Question: Summarize what this figure shows in one sentence.
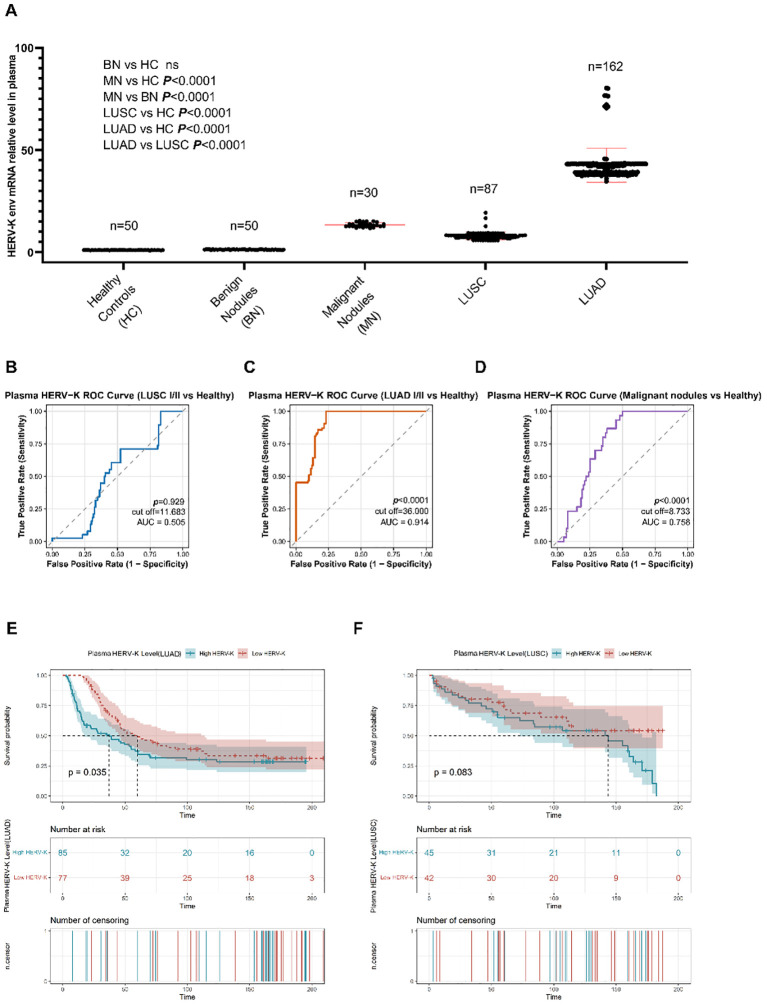
Answer: Performance of plasma HERV-K env mRNA in diagnosis and prognosis assessment with subtype-specific interpretation. (A) Plasma HERV-K env mRNA expression levels in healthy controls (HC), patients with benign pulmonary nodules (BN), malignant pulmonary nodules (MN), lung squamous cell carcinoma (LUSC), and lung adenocarcinoma (LUAD). In this study, malignant pulmonary nodules represent pathologically confirmed malignant lesions that were not further subclassified into LUAD or LUSC in the diagnostic comparison dataset. (B) ROC curve analysis of plasma HERV-K env mRNA for diagnosing early-stage squamous cell carcinoma. (C) ROC curve analysis of plasma HERV-K env mRNA for diagnosing LUAD. (D) ROC curve analysis of plasma HERV-K env mRNA for distinguishing malignant pulmonary nodules. (E) Kaplan-Meier survival curves comparing overall survival between LUAD patients with high and low plasma HERV-K env mRNA levels. (F) Kaplan-Meier survival curves comparing overall survival between LUSC patients with high and low plasma HERV-K env mRNA levels. Diagnostic performance was summarized using AUC values, and survival differences were assessed with the Kaplan-Meier method and log-rank test.